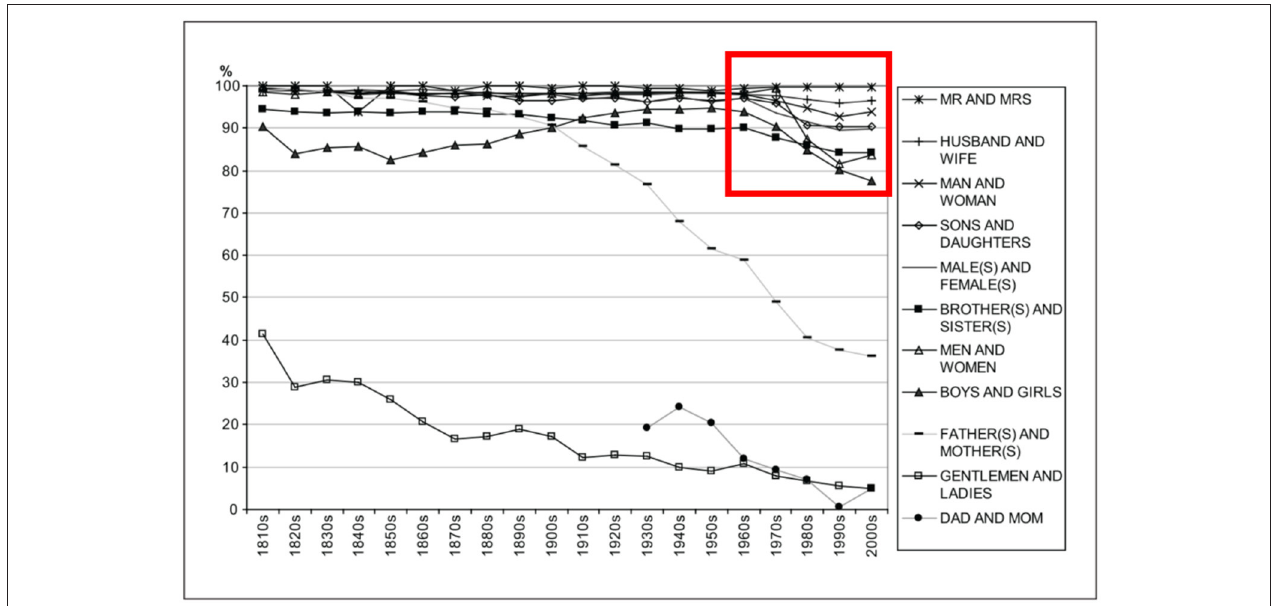
FIGURE 3 | Examples of gendered binomials which show an increasing trend away from male-first order during the 1970s as indicated by the red box (added). From Mollin (2013, Figure 9).